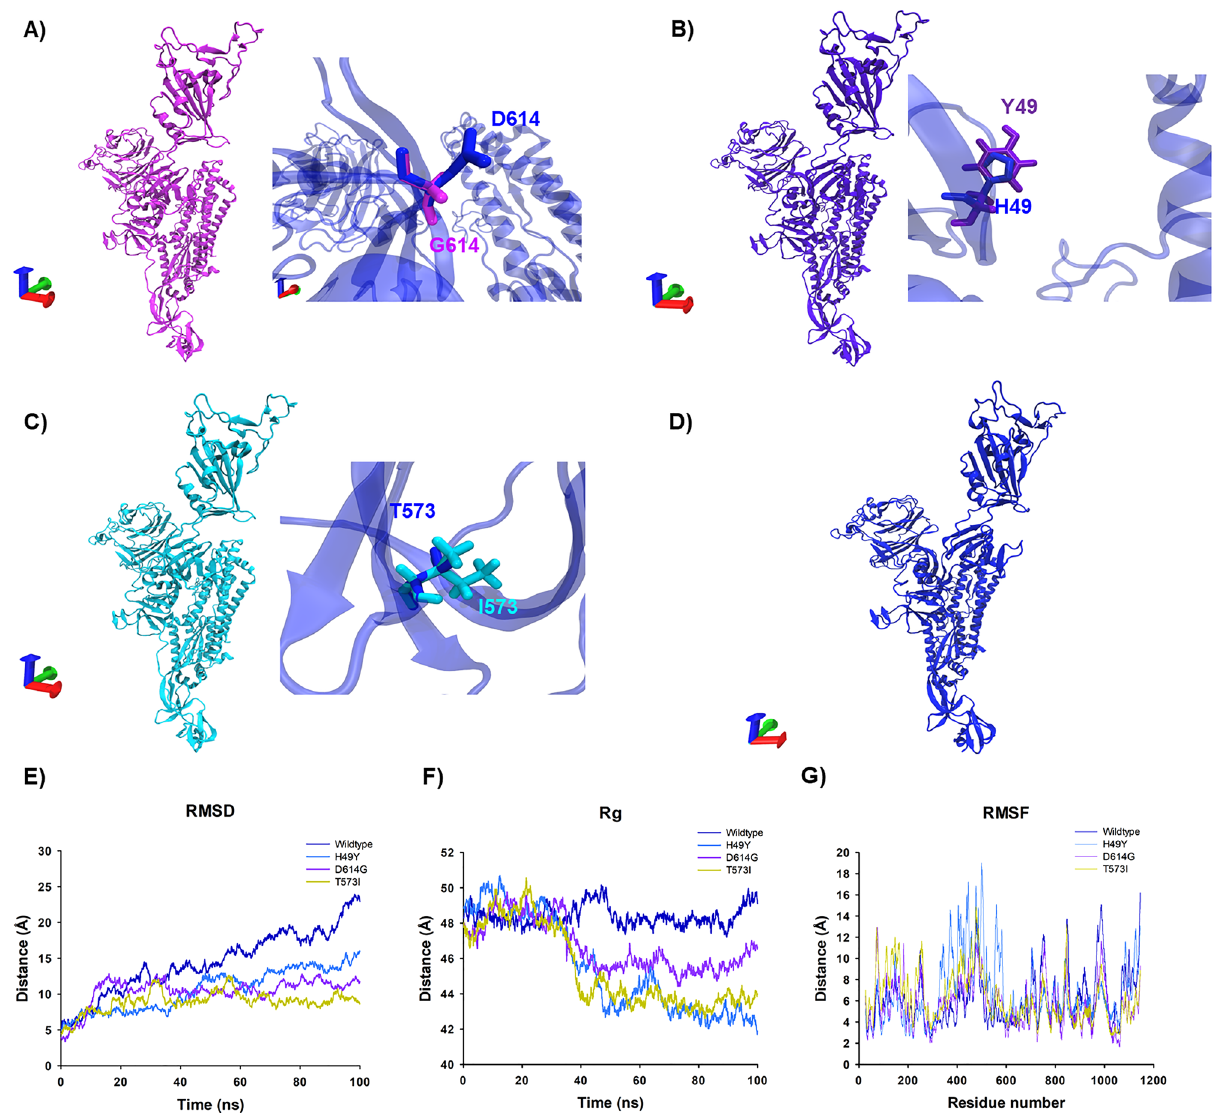
Figure 2. 3D structure and trajectory from MD simulation of Spike protein of SARS-CoV-2 and variants. ( A ) 3D Structural conformation of D614G (pink) next, the zoom of the amino acid G614 is shown in pink while the WT residue is indicated in blue. ( B ) 3D structure of H49Y (purple), the zoom of the amino acid variant Y49 is shown in purple, the WT residue is shown in the sticks in blue. ( C ) 3D structure of T573I (cyan) the zoom of the residue variant I573 is shown cyan while the WT residue T573 is indicated in blue sticks. ( D ) 3D structure of wild type S protein is shown in blue. Axes: X, red; Y, green; Z, blue. The structural analysis was carried out by RMSD ( E ), Radius of gyration ( F ) and the RMSF ( G ). The trajectories of the WT are shown in navy blue, D614G are shown in purple, H49Y are shown in blue and T573I are shown in